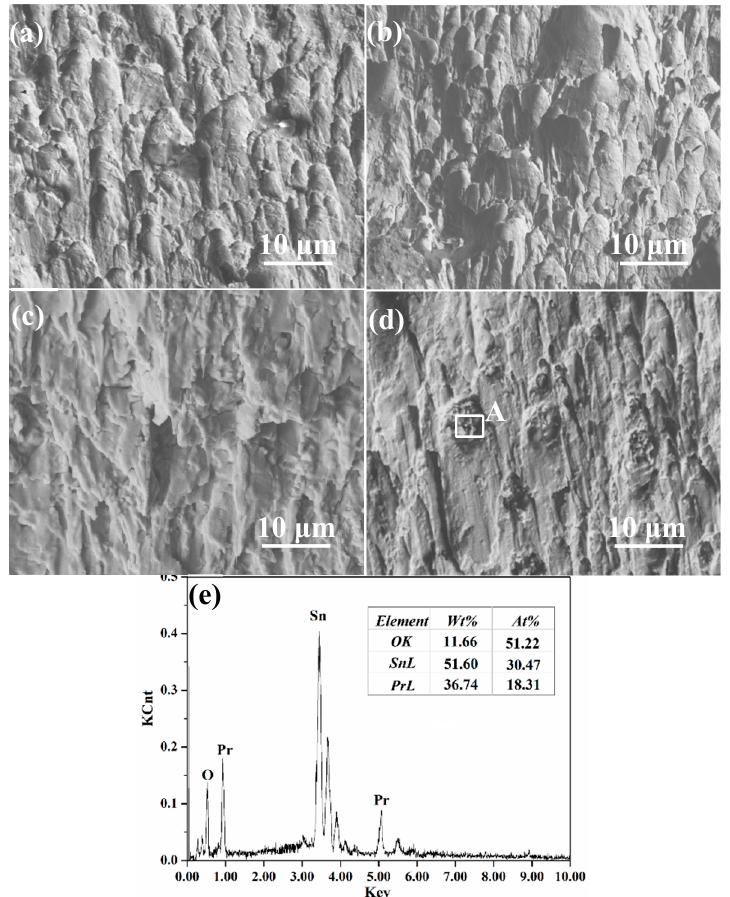
Figure 7. ( a ) Illustration of shearing process; ( b ) Changes in shear strength at Sn-0.3Ag-0.7Cu solder/Cu and Sn-0.3Ag-0.7Cu-0.05Pr/Cu solder aged for different hrs.